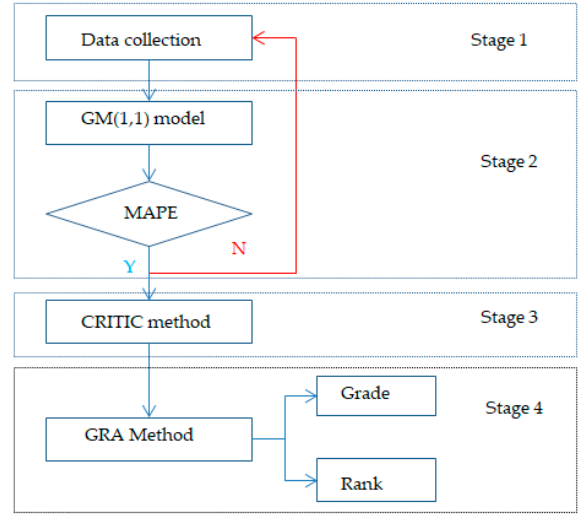
Figure 1. Research framework.